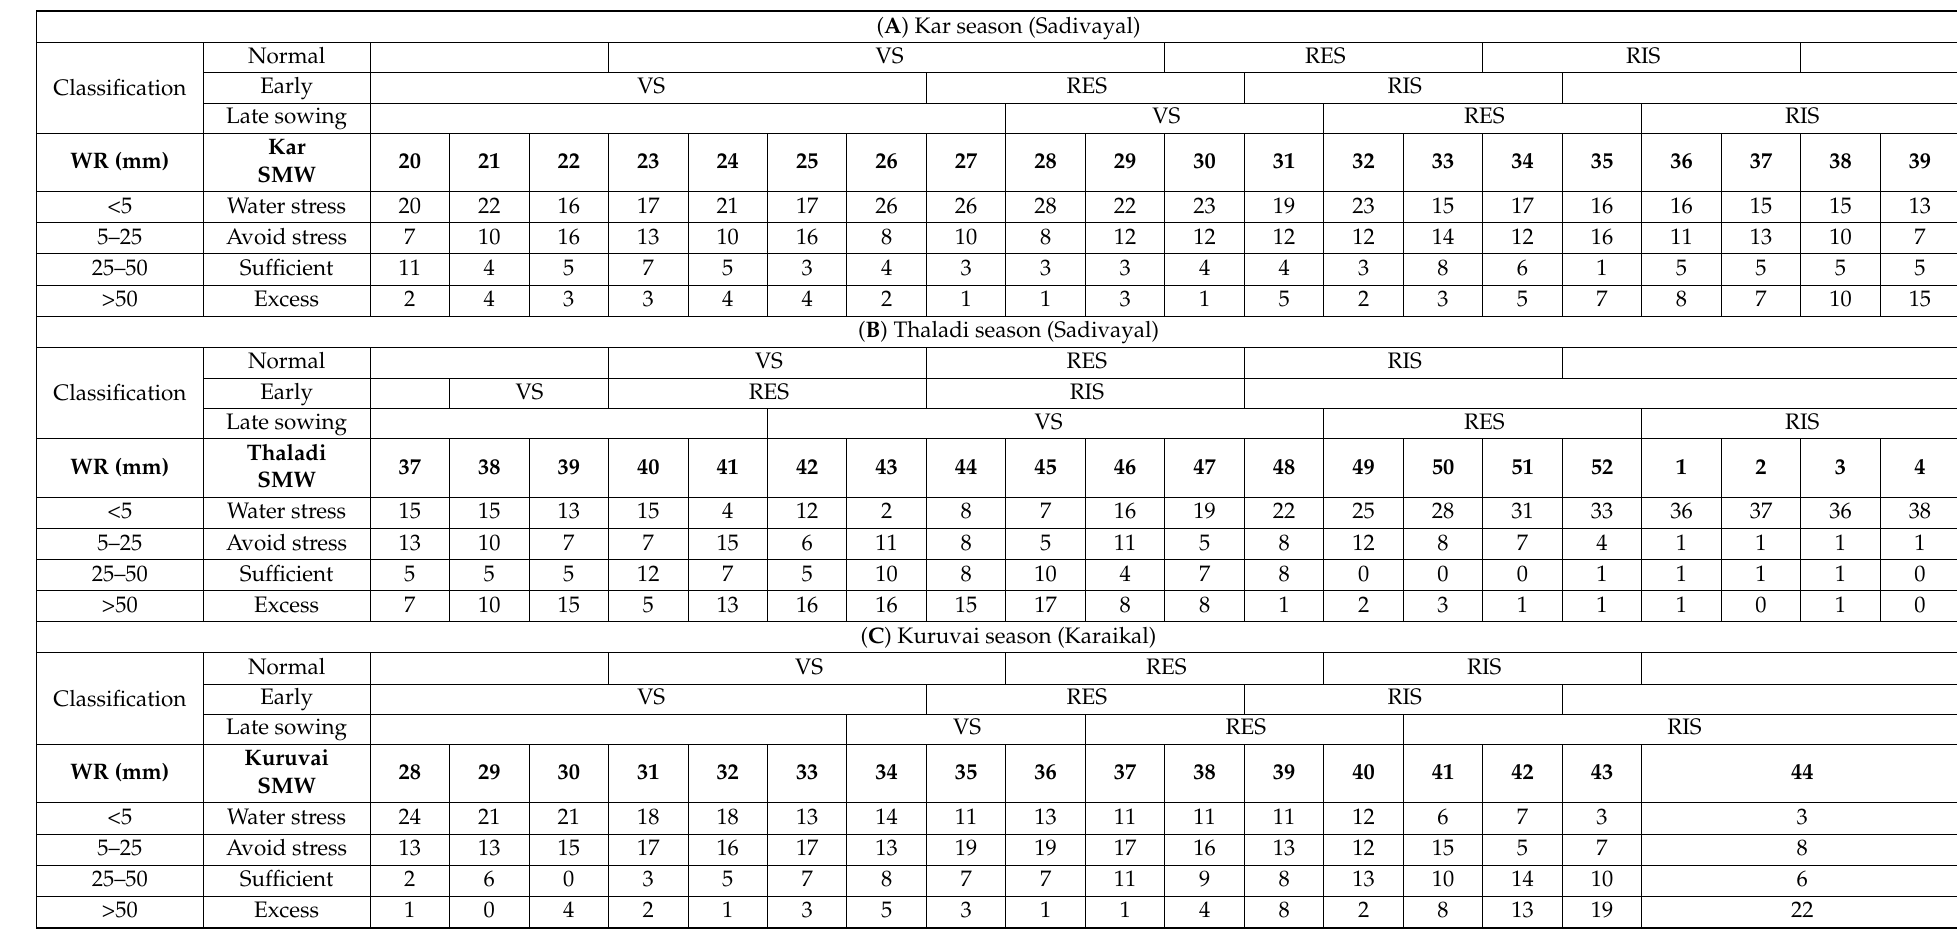
Table 6. Water availability assessment based on weekly rainfall